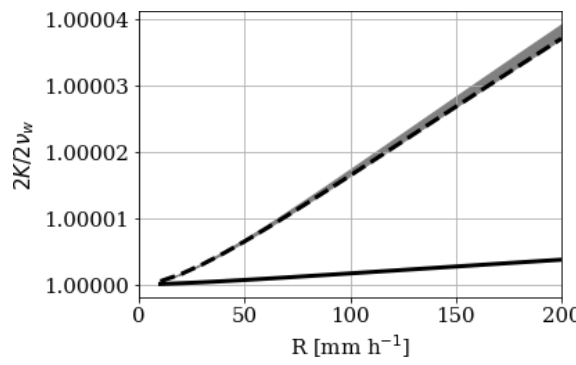
Figure 3. Relative effective wave dissipation 2 K/ 2 ν w , as a function of rain rate R for two values of the unconstrained parameter, c e , with 1 (solid) and 0.1 (dashed). The very small region with the gray shading, below the upper curve, corresponds to a variation in air diffusivity between 10 − 5 ms − 2 (dashed line) and 10 − 4 ms − 2 for a fixed c e = 0 . 1. The figure highlights that the model outcomes are more sensitive to the parameter c e than to the value of the diffusivity ν a